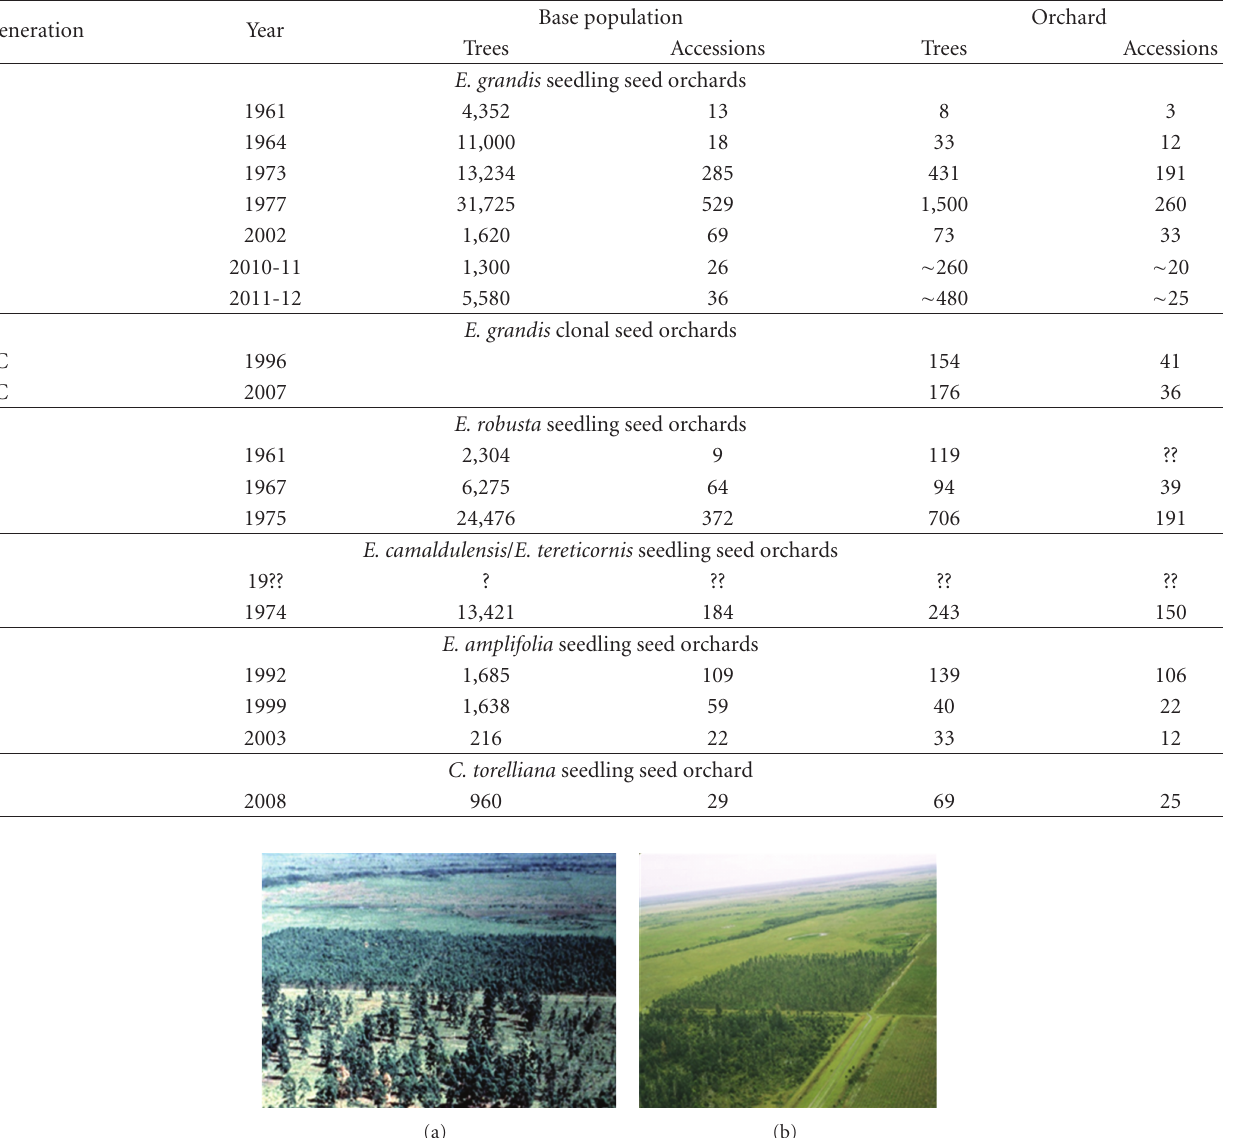
Table 1: Numbers of trees and accessions in Florida Eucalyptus grandis , E. robusta , E. camaldulensis / E. tereticornis , E. amplifolia , and